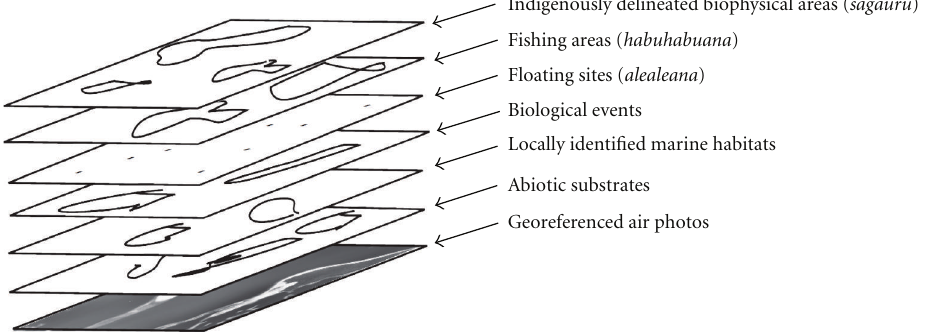
Figure 2: Indigenous hierarchical cognition of the seascape as represented by layers (or themes) in the GIS [45].